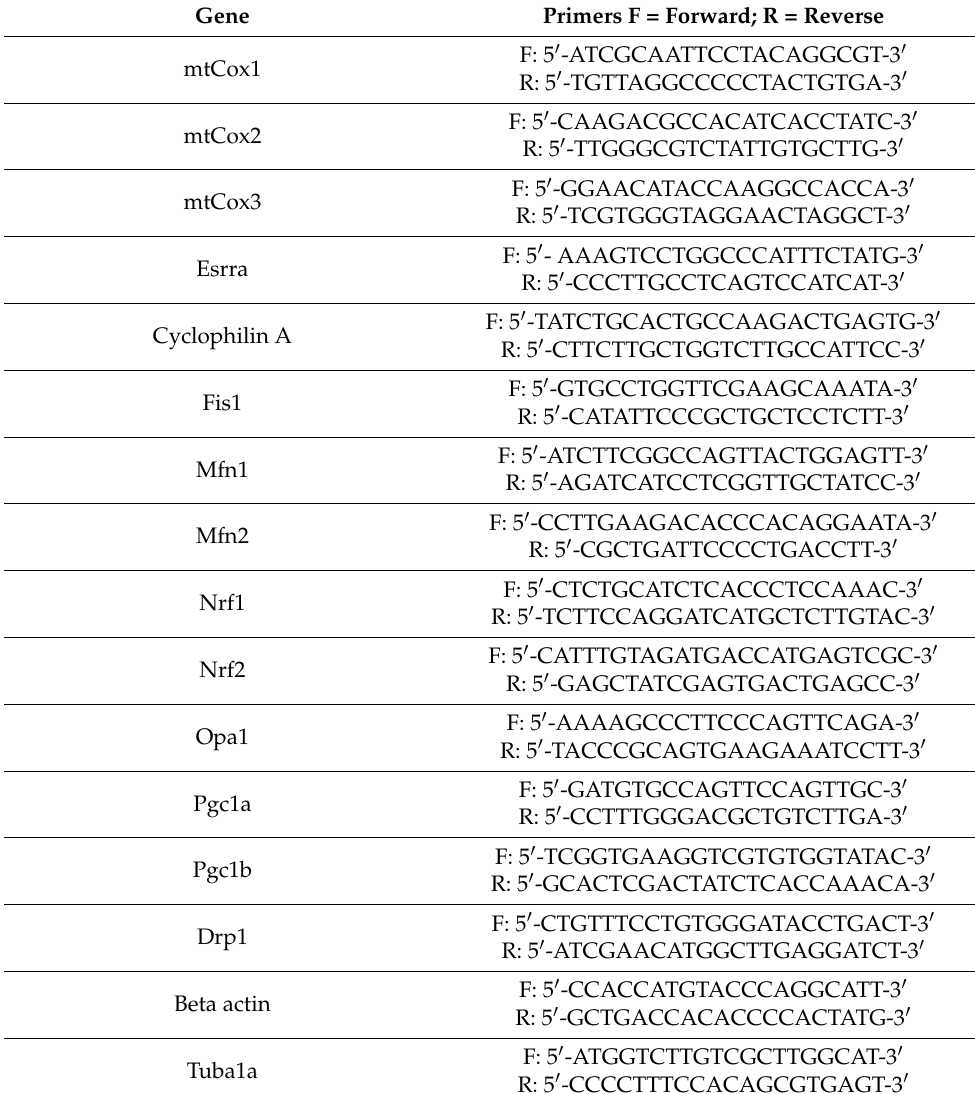
Table 1. Oligonucleotide primers used for real-time